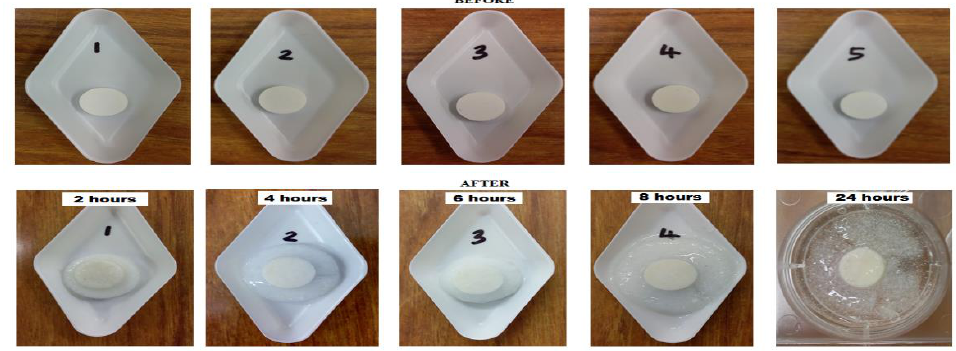
Figure 3. Swelling behavior comparison for bilayer tablets in 2% SDS aqueous solution (pH 4.2), at different time intervals.